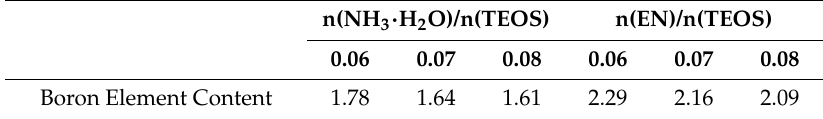
Table 1. Boron element content of SiBCO aerogel prepared with different basic catalysts.